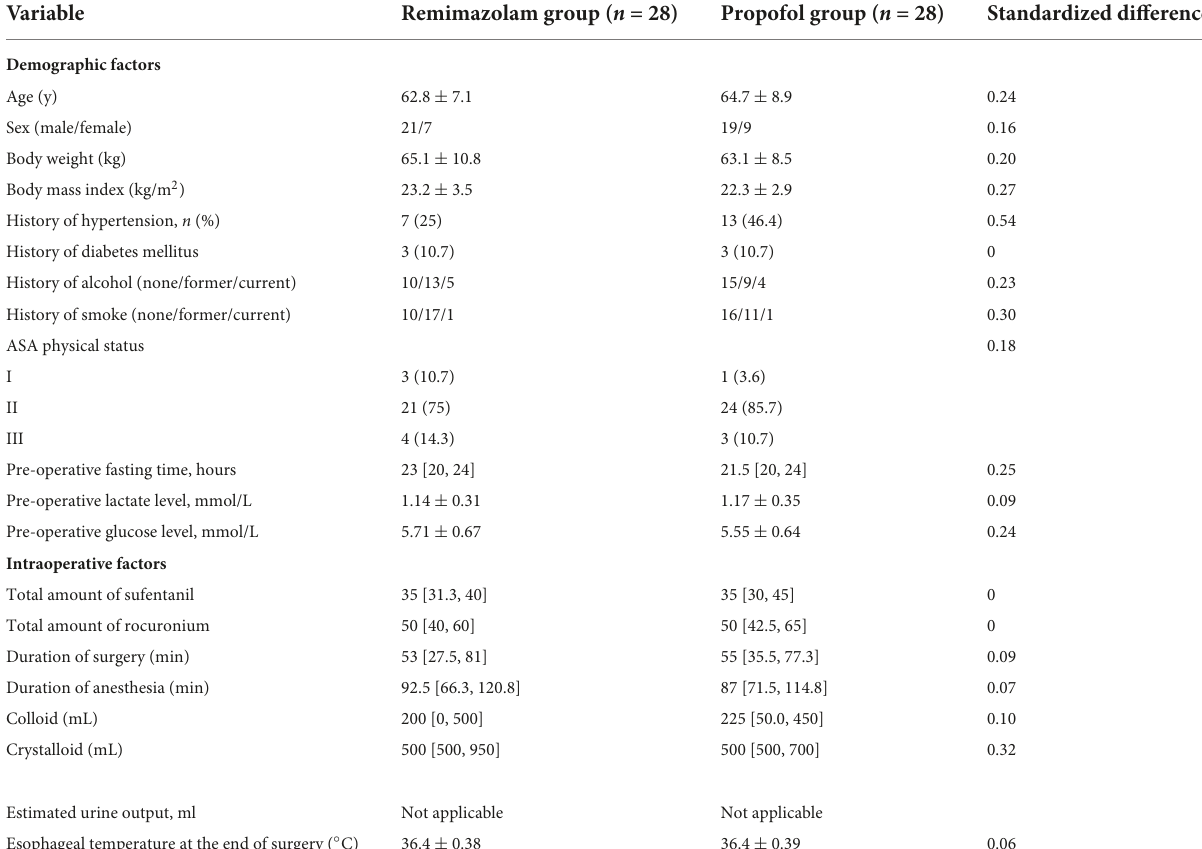
TABLE 1 Baseline characteristics of patients receiving remimazolam or propofol.